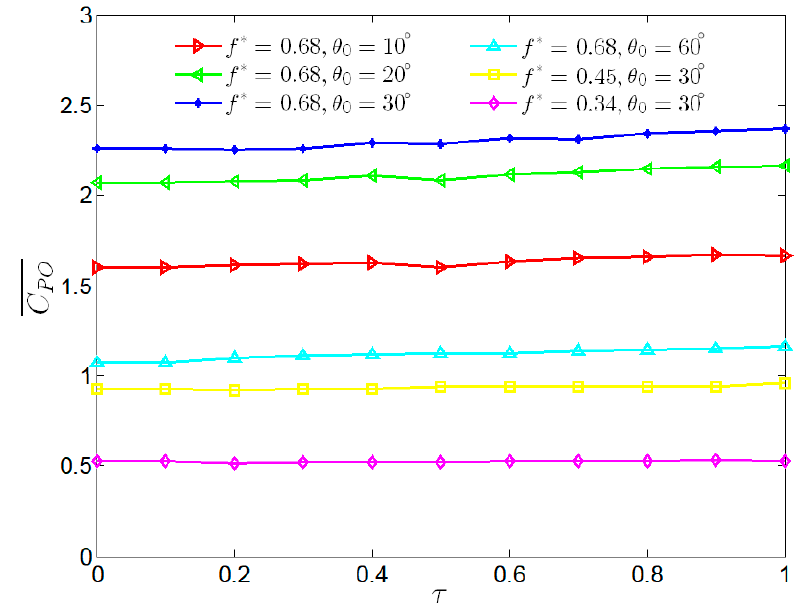
Figure 9. The evolution of the mean propulsion power coefficient with the variation of the oscillating frequency coefficient.